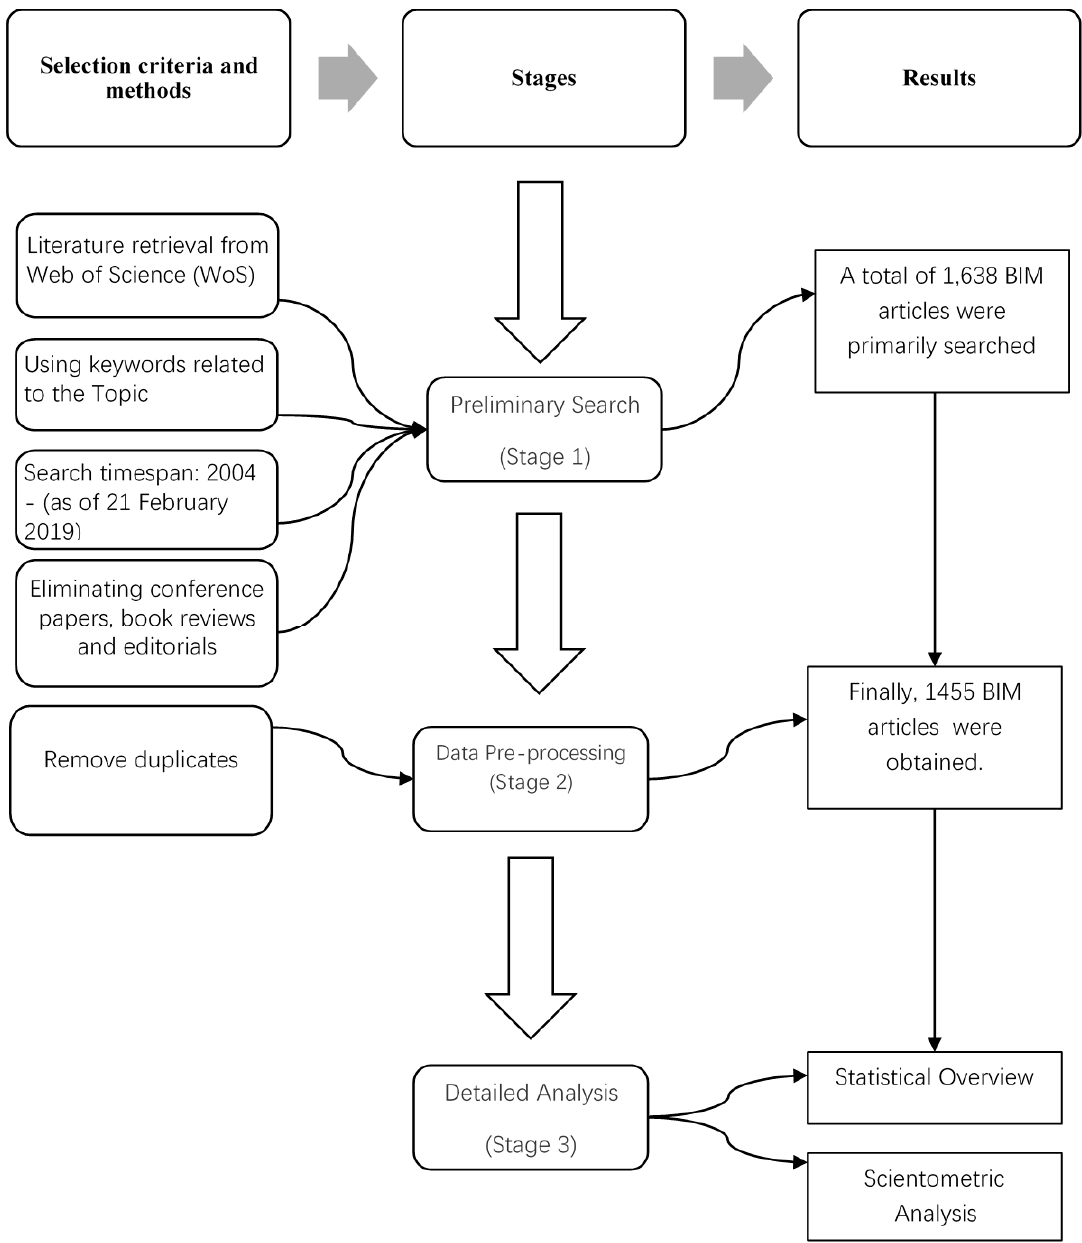
Figure 1. Research Framework.